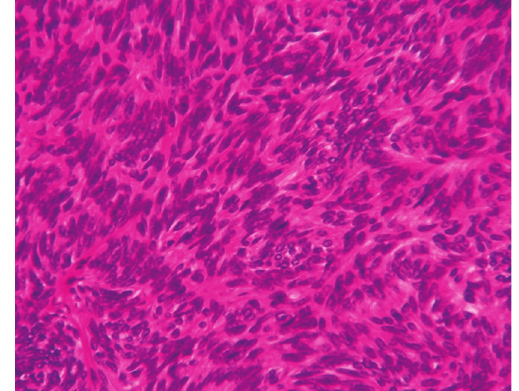
Figure 2: Yellowish homogeneous ovoid areas and arborizing vessels at the periphery of the nodule.